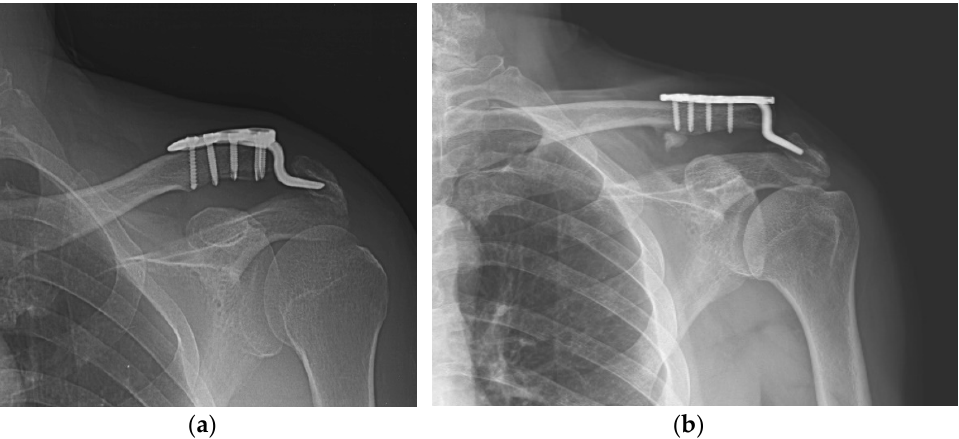
Figure 7. Loss of reduction in acute acromioclavicular joint dislocation. ( a ) With severe acromial erosion; ( b ) with acromial fracture. Table 3. Frequency of painful shoulder stiffness in specific